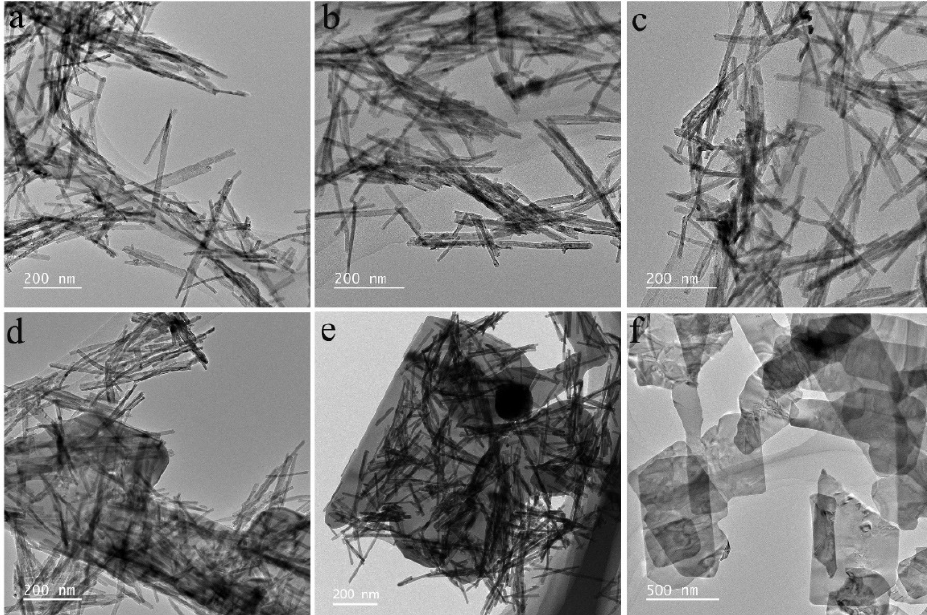
Figure 3. TEM images of the CuO/CeO 2 catalysts: ( a ) CeO 2 nr, ( b ) 10%Cu/Ce, ( c ) 20%Cu/Ce, ( d ) 50%Cu/Ce, ( e ) 80%Cu/Ce, and ( f ) CuO.